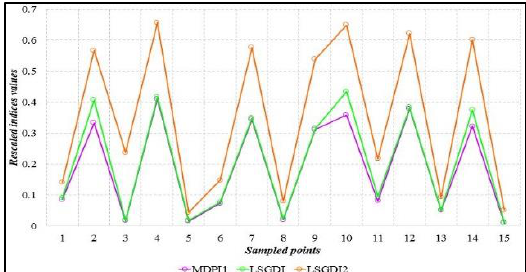
Figure 11. Reflectance of the three indices for April 2018